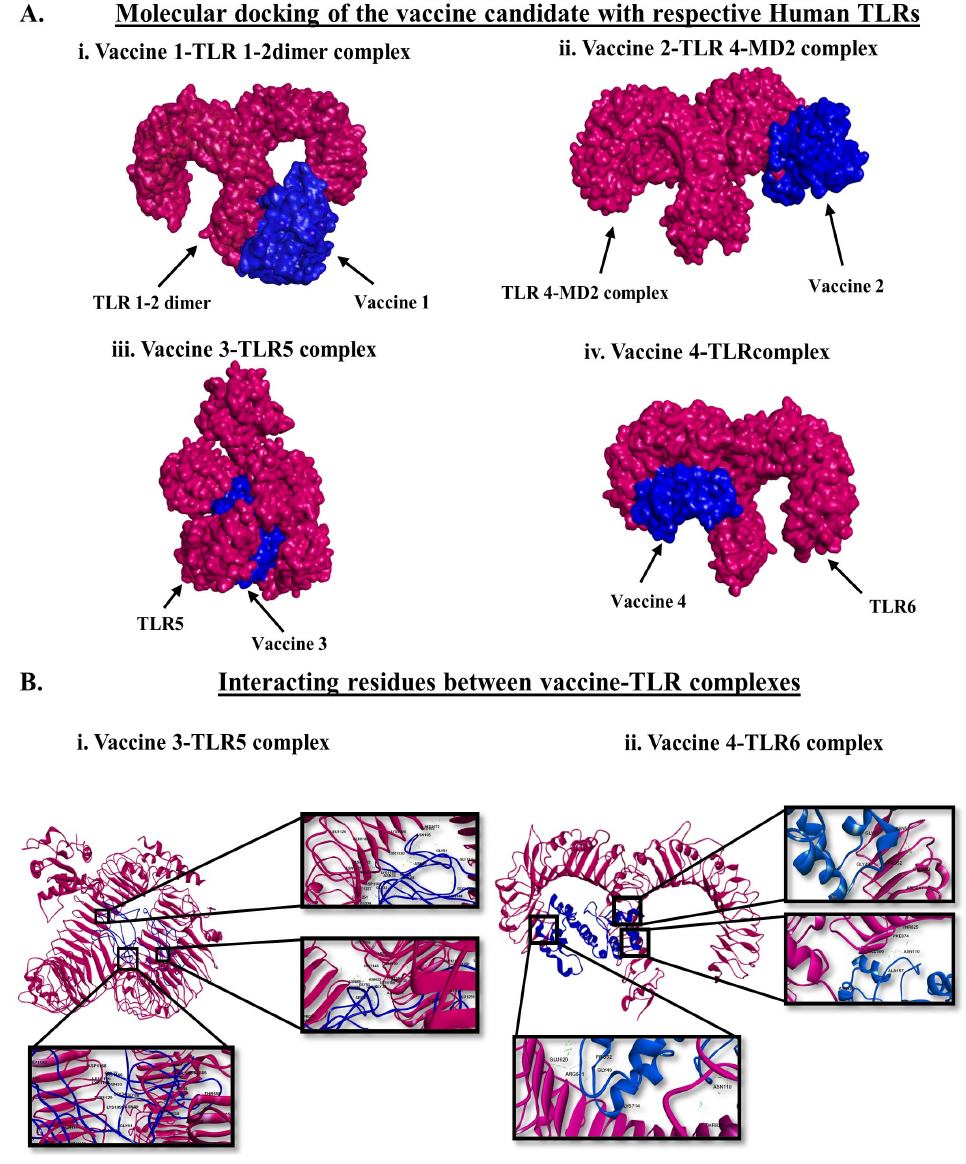
Figure 3. Molecular docking and biomolecular interaction between the vaccine candidates and human TLRs. ( A ). Molecular docking between ( i ). VACCINE l with TLR1/2 dimer, ( ii ). VACCINE 2 and TLR4–MD2 complex, ( iii ). VACCINE 3 and TLR5, and ( iv ). VACCINE 4 with TLR6. ( B ). Interacting residues participating in the molecular docking between ( i ). VACCINE 3 and TLR5, and ( ii ). VACCINE 4 with TLR6. Table 5. Interactions between the Vaccine candidate and the targeted